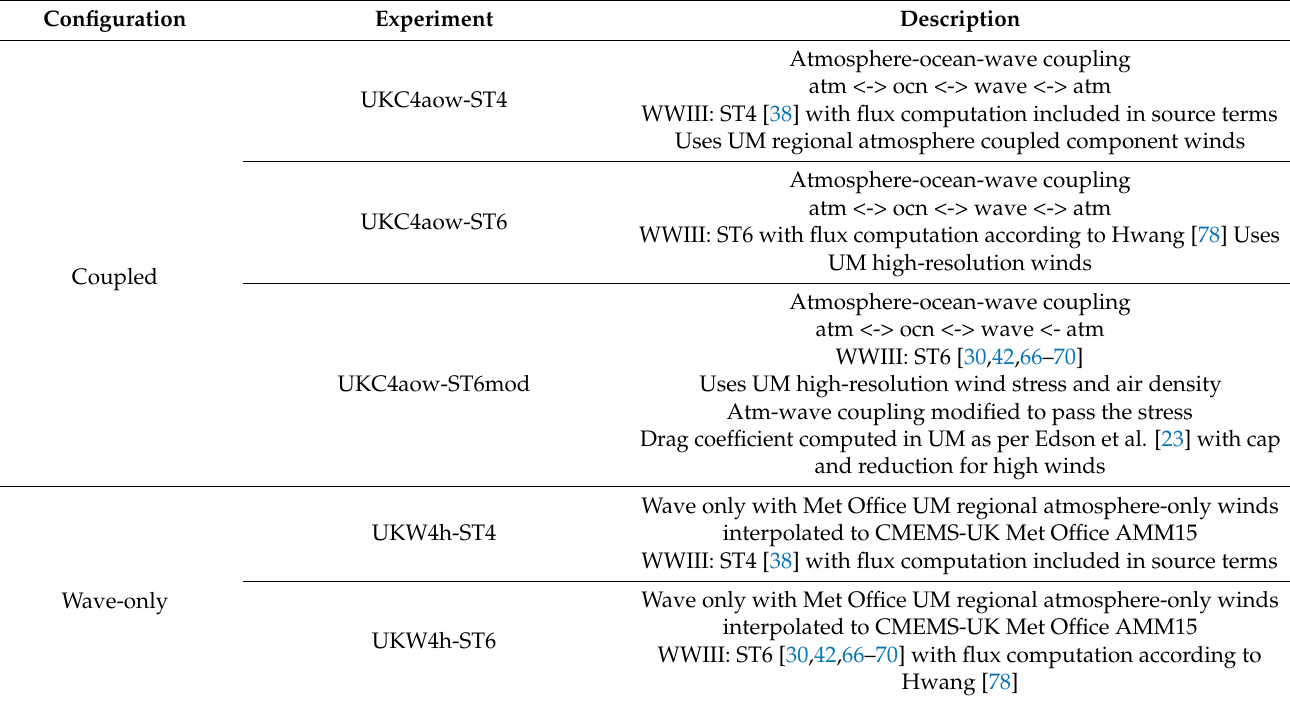
Table 2. Experiments